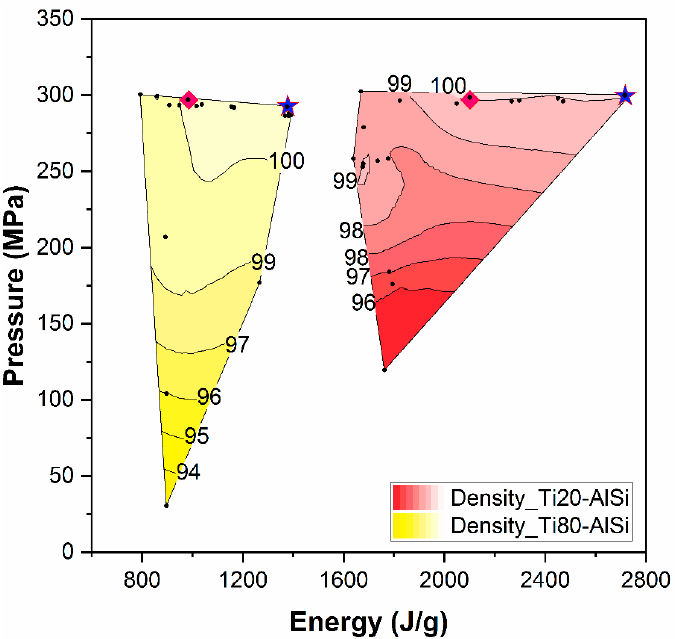
Figure 1. Processing map reporting in isodensity areas, the density measured for each sample produced (black dot). Blue stars identify high-energy samples, while pink diamonds are for low-energy ones.